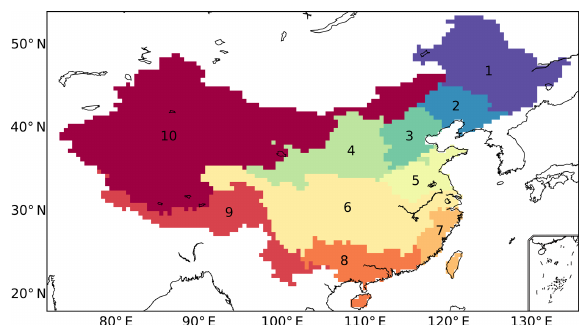
Figure 3. Ten subregions are defined in this study. These subregions are mainly river basins (Regions 1–8), but 9 is Southwest China and 10 is Northwest China. Region 11 is the entirety of the Chinese